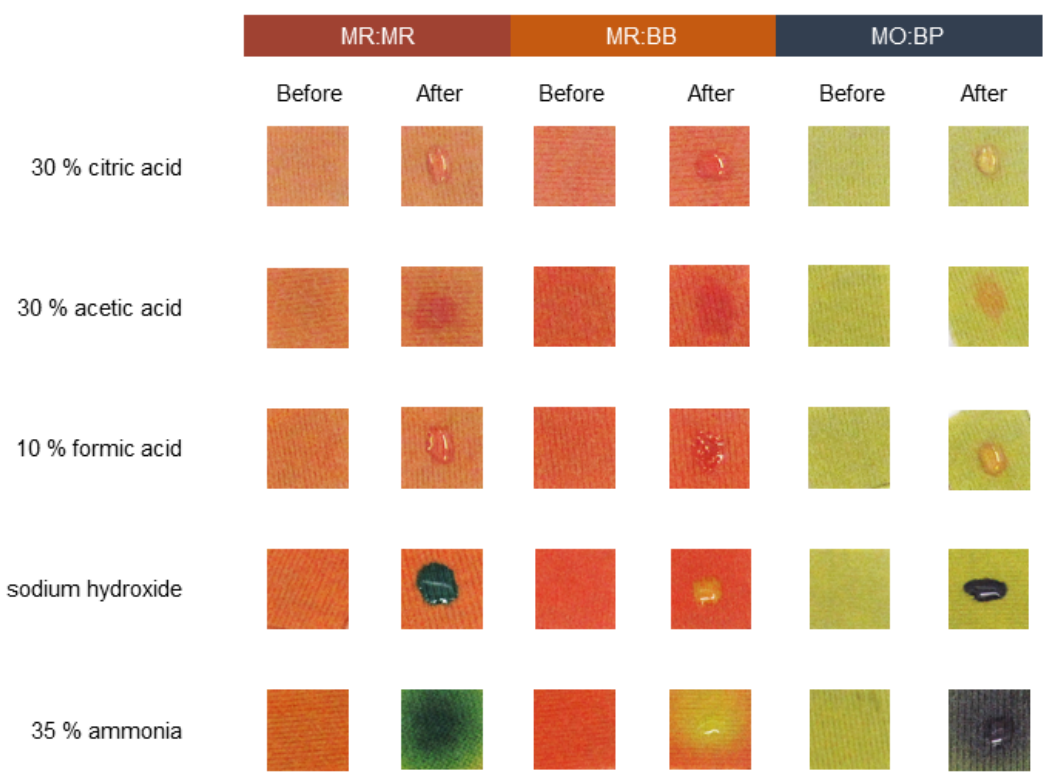
Figure 7. Sensitivity of cotton knits functionalized with different pH sensors, to acidic and basic solutions. The sensors used were: methyl red and bromothymol blue (MR:BB); methyl red and me- thyl red sodium salt (MR:MR); and methyl orange and bromocresol purple (MO:BP).